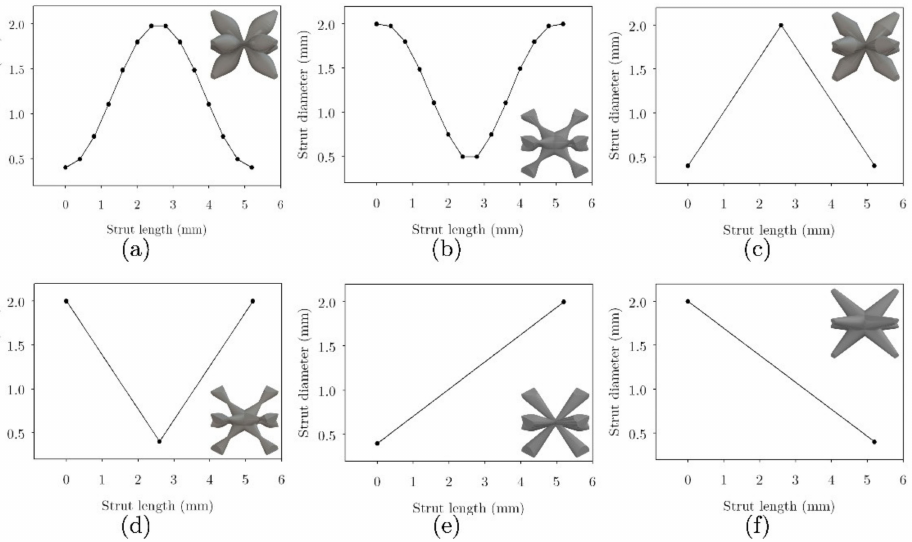
Figure 3. Cross-section variation: Type of variation ( a ) Cosine (COS), ( b ) Cosine2 (COS2), ( c ) Double Slope (DS), ( d ) Double Inverted Slope (DIS), ( e ) Negative Slope (NS) and ( f ) Positive Slope